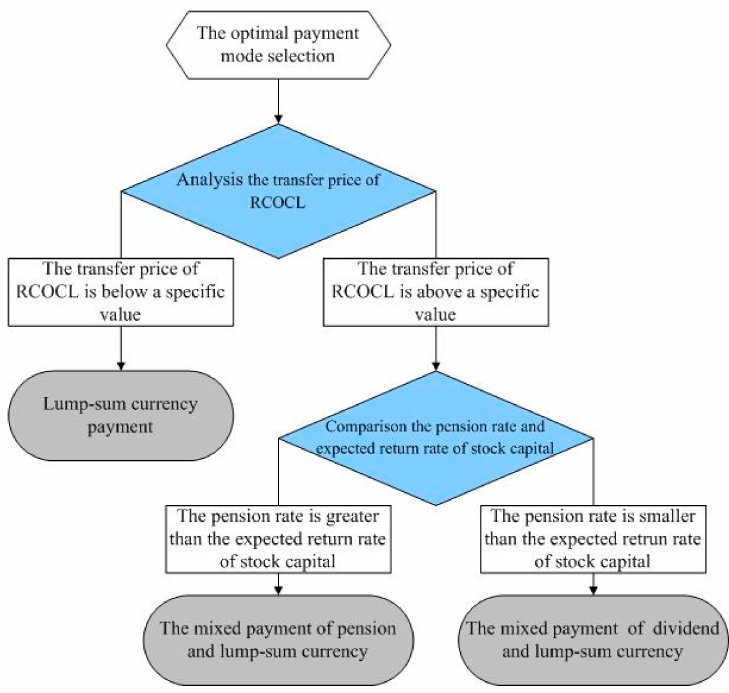
Figure 3. The process of selecting the optimal payment mode. Table 2. The preference of optimal payment